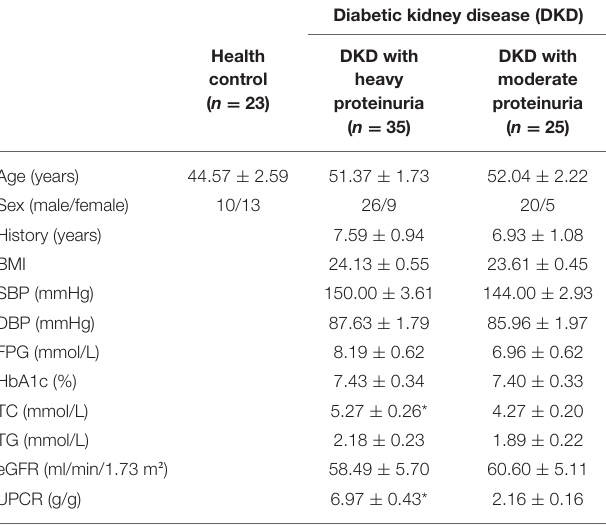
TABLE 3 | Characteristics of individuals included in the VERIFICATION group. Diabetic kidney disease